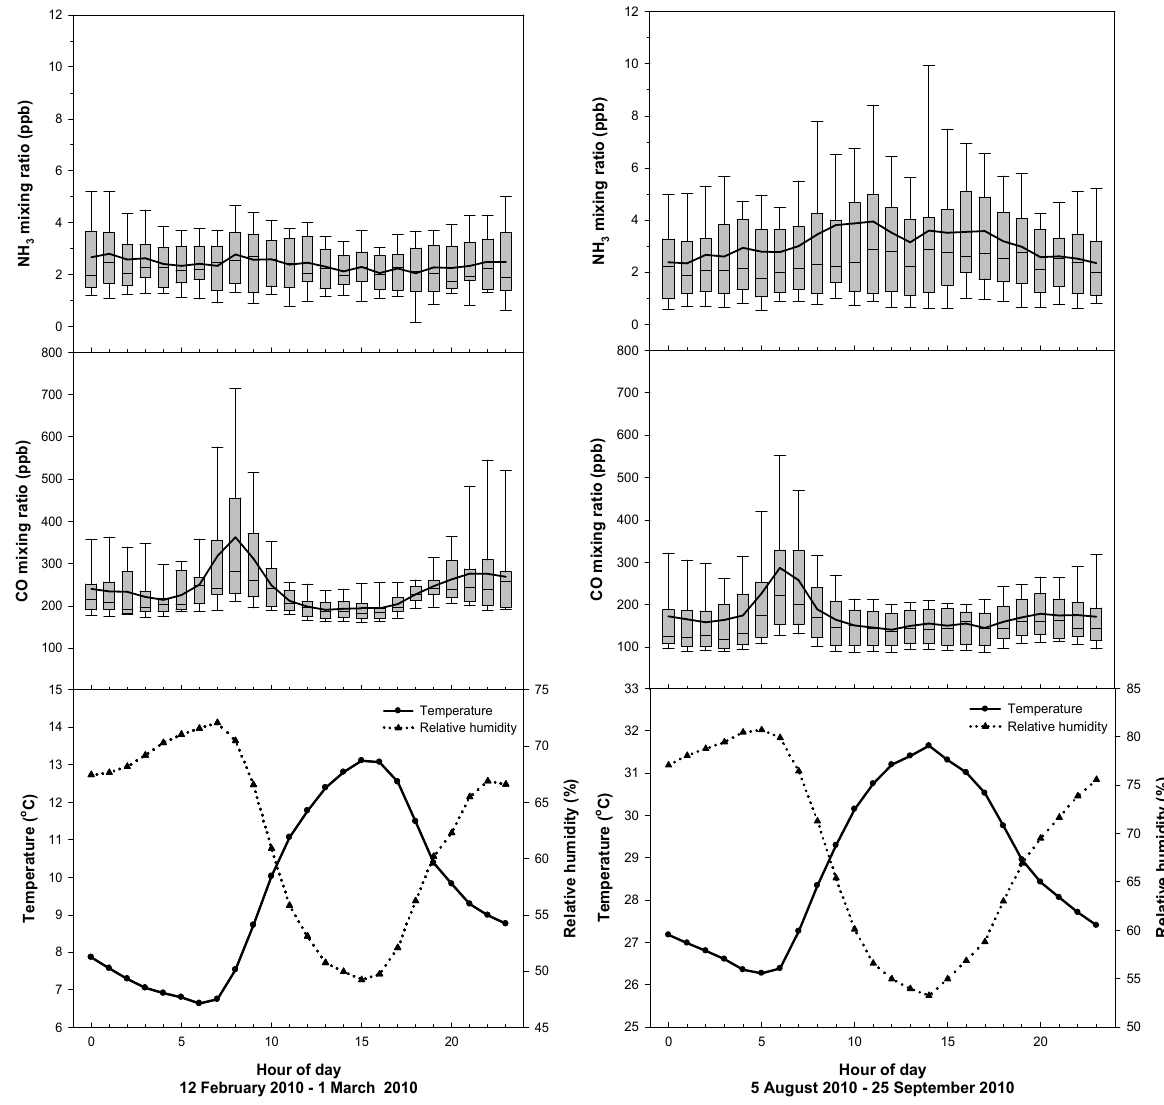
Fig. 3 (a). Fig. 3 (b). Fig. 3. Diurnal profiles of NH 3 and CO mixing ratios as well as temperature and relative humidity during the two sampling periods. The bottom whisker, box bottom, line inside the box, box top, and top whisker represent the 10th, 25th, 50th, 75th, and 90th percentiles of the data, and the continuous lines represent mean values, respectively. (a) 12 February–1 March 2010; (b) 5 August–25 September